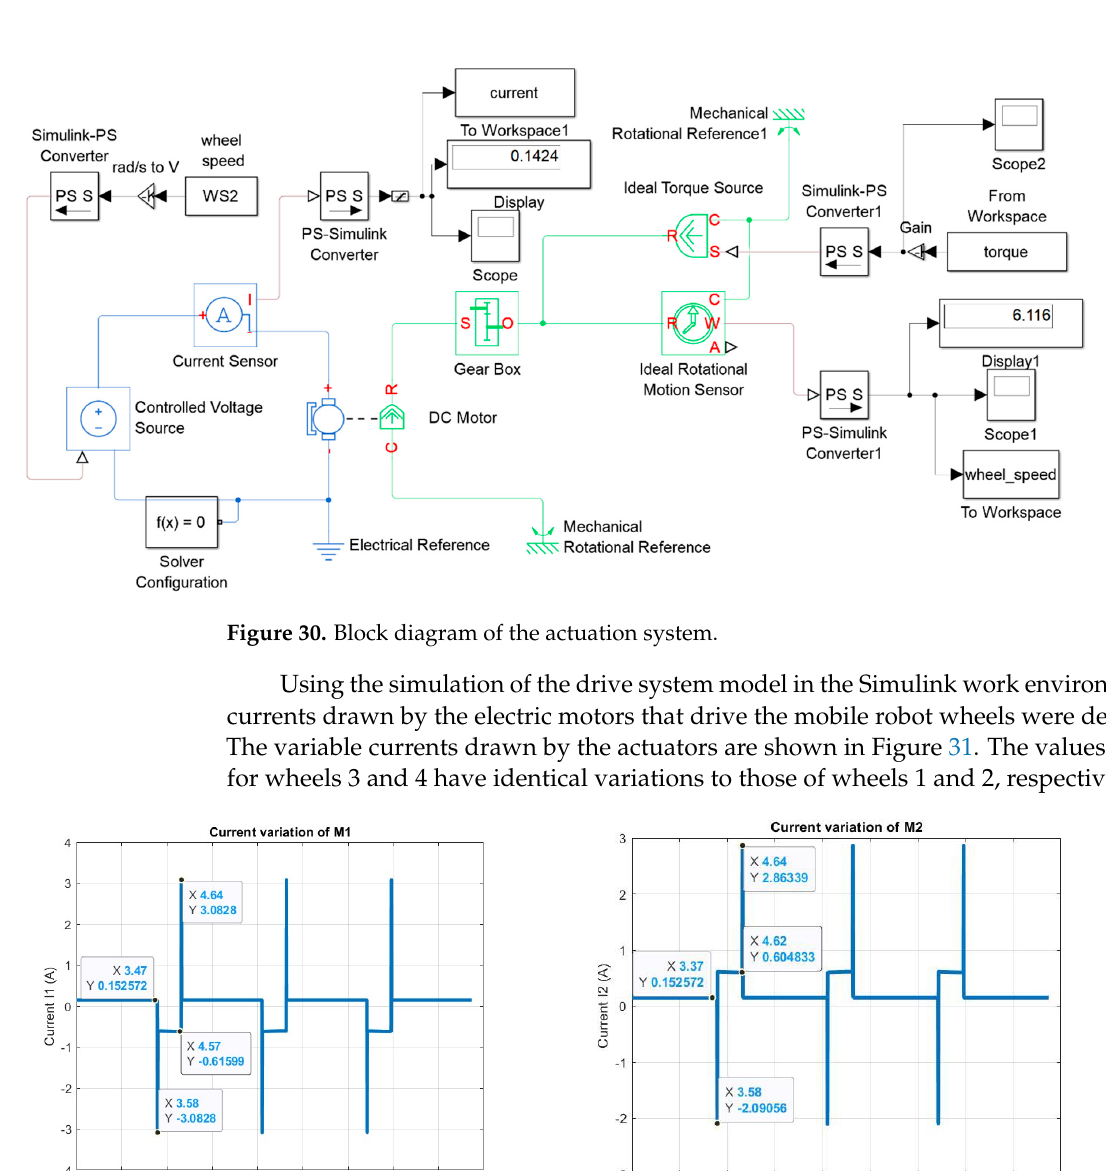
Figure 31. Current variation determined in the model simulation for a 1 m square trajectory. ( a ) Wheel 1 (similar to wheel 3). ( b ) Wheel 2 (similar to wheel 4).